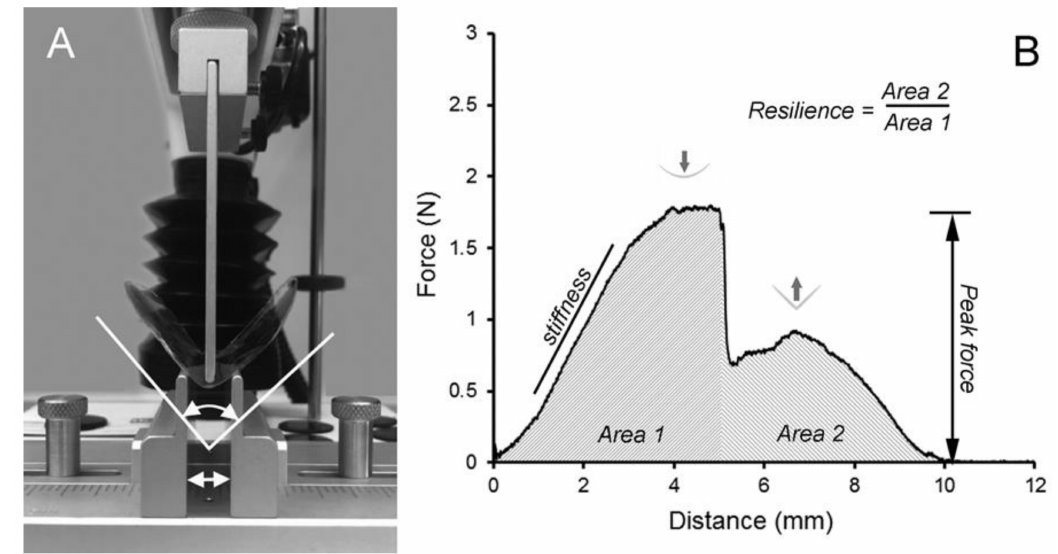
Figure 4. Flexural properties of LMP films. ( A ) To test the flexural properties of the LMP films, a 3-point custom bend fixture with 12 mm separation (double arrow) of the support blades was used. The upper blade was positioned equidistant from the support blades and was applied at constant velocity (2 mm / s) for a distance of 5 mm after film contact. ( B ) The applied force required for a 5 mm displacement was recorded in Area 1. The force recorded on blade withdrawal (storage modulus) was recorded in Area 2. Resilience was calculated as the ratio of Area 2 / Area